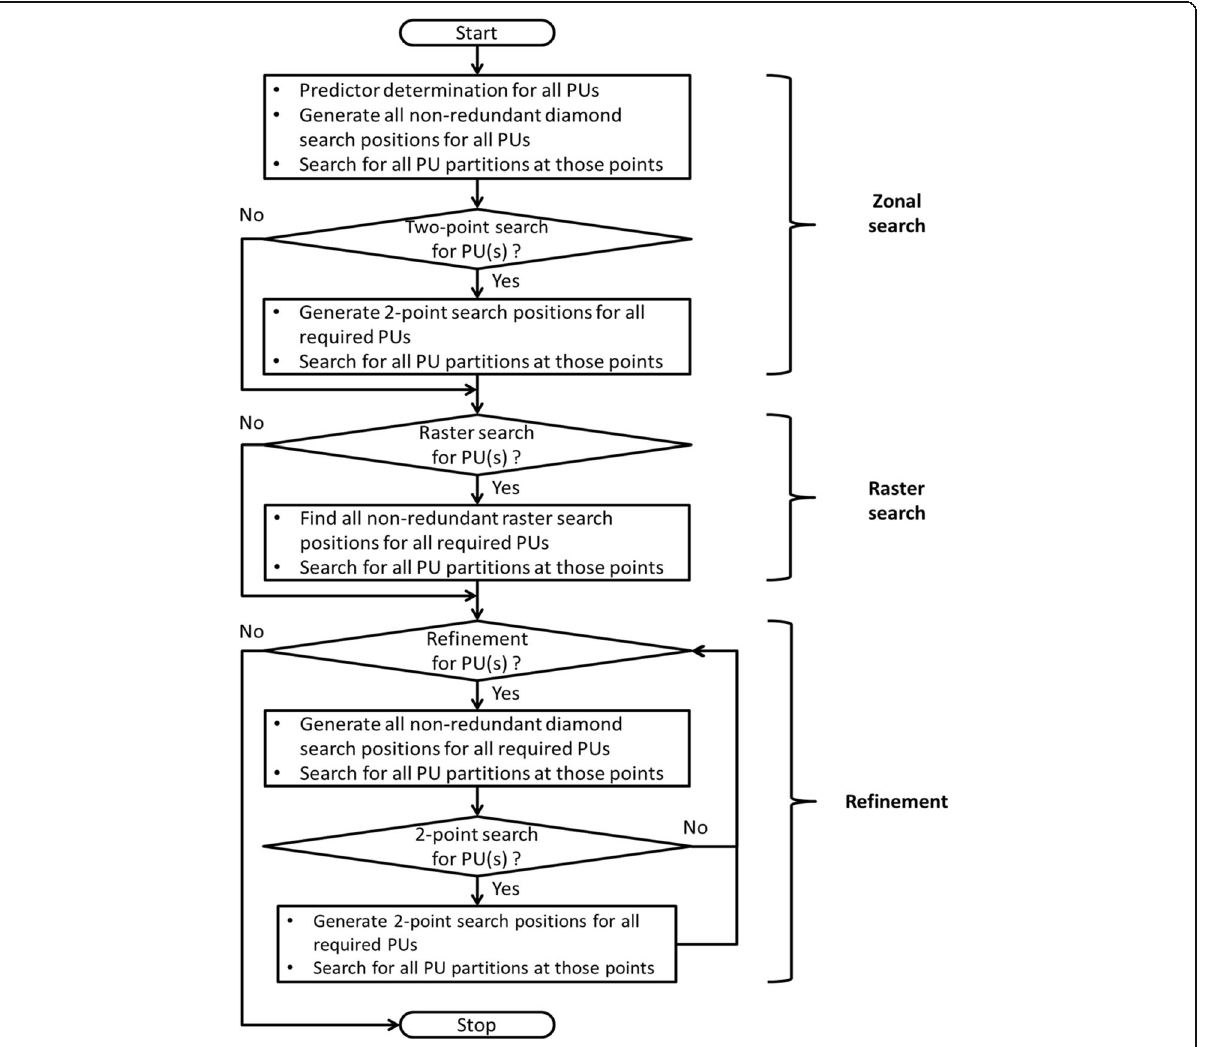
These search center positions of the 2N × 2N, N × 2N part-0, and N × 2N part-1 PUs are represented by three gray marks in the shape of a circle, a rectangle, and a tri- angle, respectively. Subsequently, all search positions with the diamond pattern are generated for all PUs; the black marks in the shapes of a circle, a rectangle, and a triangle represent the search positions required for the corresponding PUs. For instance, all black circles belong to the search path of the 2N × 2N PU, the black rectan- gles are those for the N × 2N part-0 PU, while in the case of the N × 2N part-1 PU, its search positions are il- lustrated by the black triangles. When all search points are completely created for all available PUs, redundant search positions can exist owing to the fact that the search centers of all PUs are often located closely to each other. A black circle covering a generated